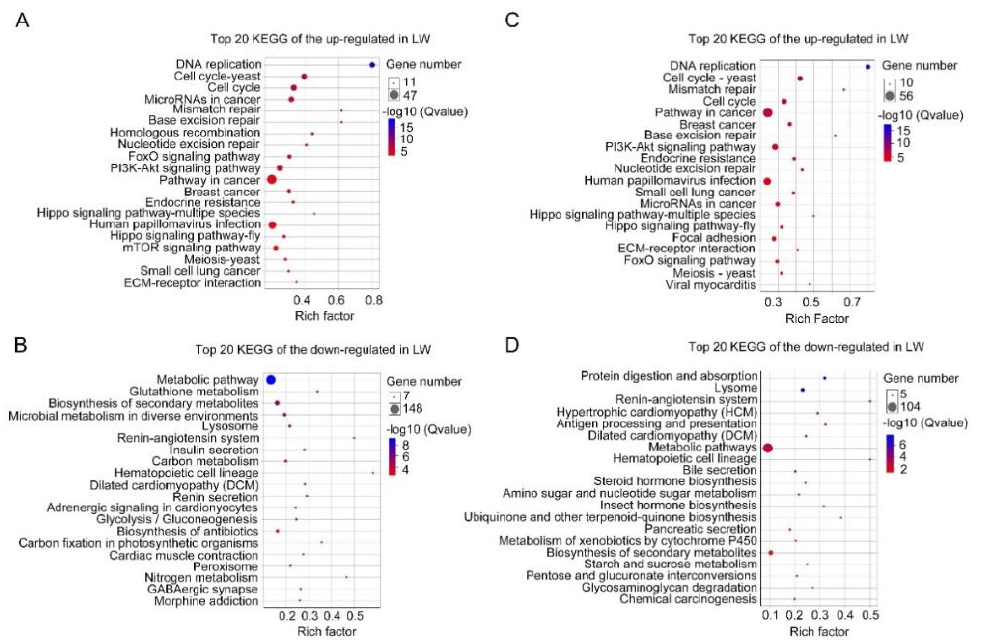
Figure 7. Top 20 enriched KEGG pathways of DEGs in 36 hAE-5th-instar nymphs with NlFoxO and Gfp knockdown. ( A , B ) Top 20 enriched KEGG pathways of up-regulated and down-regulated genes in forewing buds, respectively. ( C , D ) Top 20 enriched KEGG pathways of up-regulated and down-regulated genes in hindwing buds, respectively. The q -values in different colors denote significant enrichment. Different sizes of dots represent the number of genes enriched in each pathway.